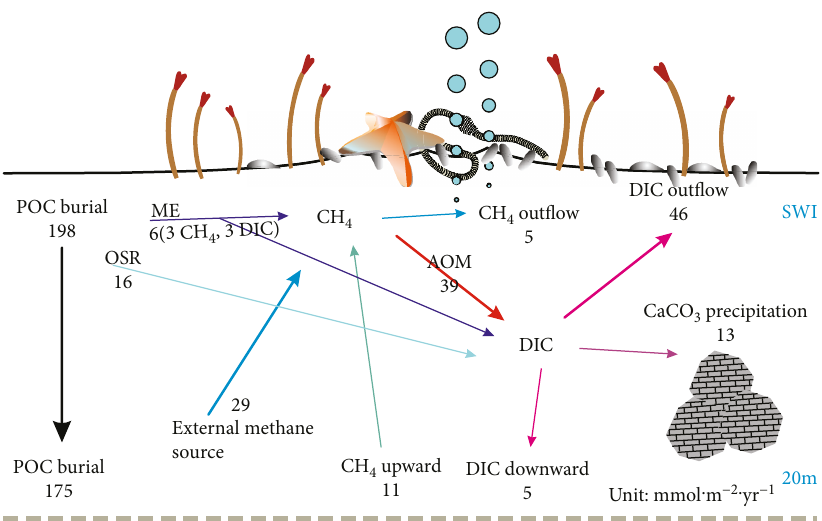
Figure 4: Shallow carbon cycling in the cold seeps and gas hydrate-bearing sediments in the northern South China Sea. The numbers in bold represent mean values of interpolation mean and arithmetic mean (Table 1). The numbers in italic are derived from the model. The number in grey is estimated considering methane mass